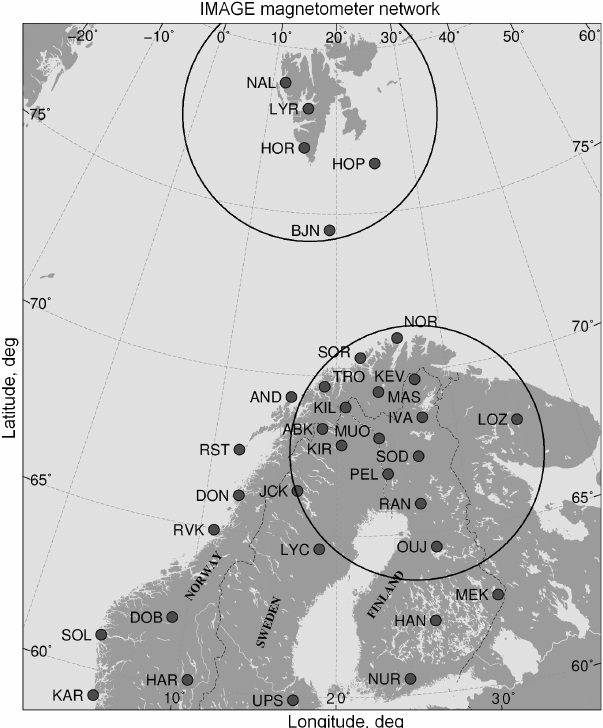
Figure 1. Observatories of the IMAGE magnetometer network (small black dots). Large circles show the field of view of the all-sky cameras in Barentsburg (BAB; top) and Sodankylä (SOD;